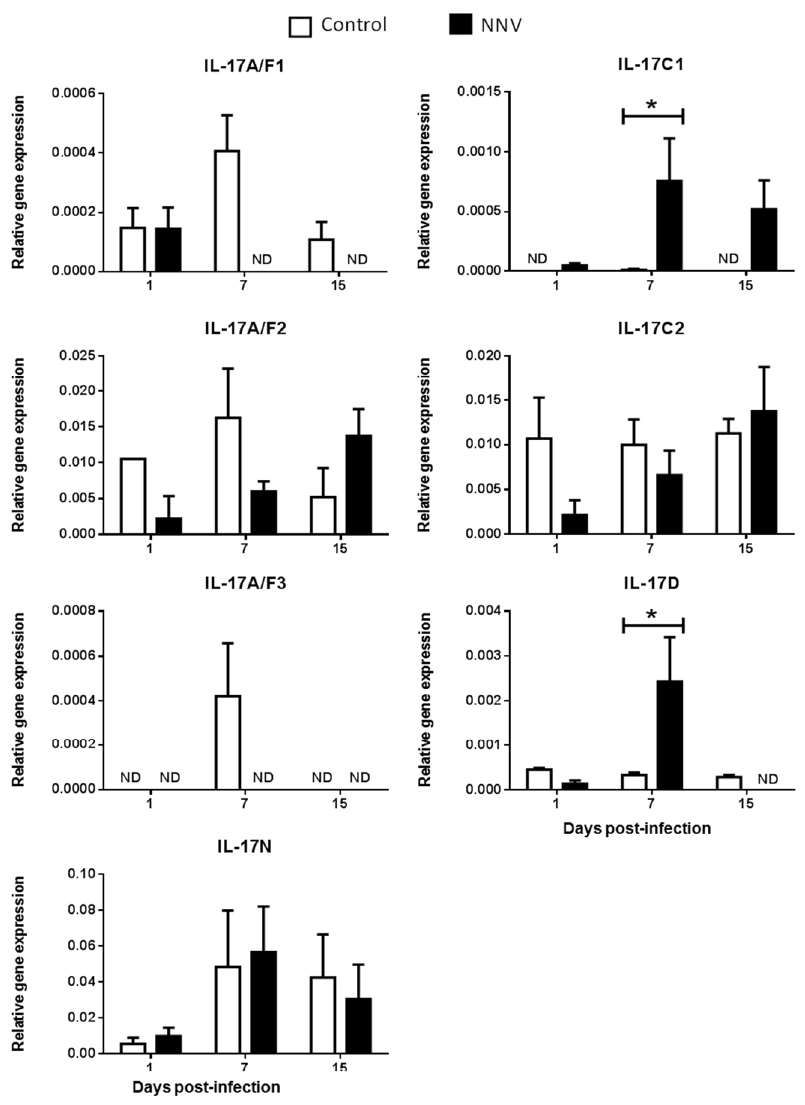
Figure 5. Nodavirus regulates the transcription of European sea bass IL-17 genes in the brain. The relative gene expression of IL-17 ligands in the brain of European sea bass specimens intramuscularly injectedwith100 µ Lofculturemediumalone (control)or containing10 6 TCID 50 ofnodavirus(NNV) / fish. The data are presented as the mean ( n = 4–6) ± SEM relative to the expression of the endogenous controls. Asterisks denote significant di ff erences with the control group at each sampling time ( Student-t -test, p < 0.05). ND,